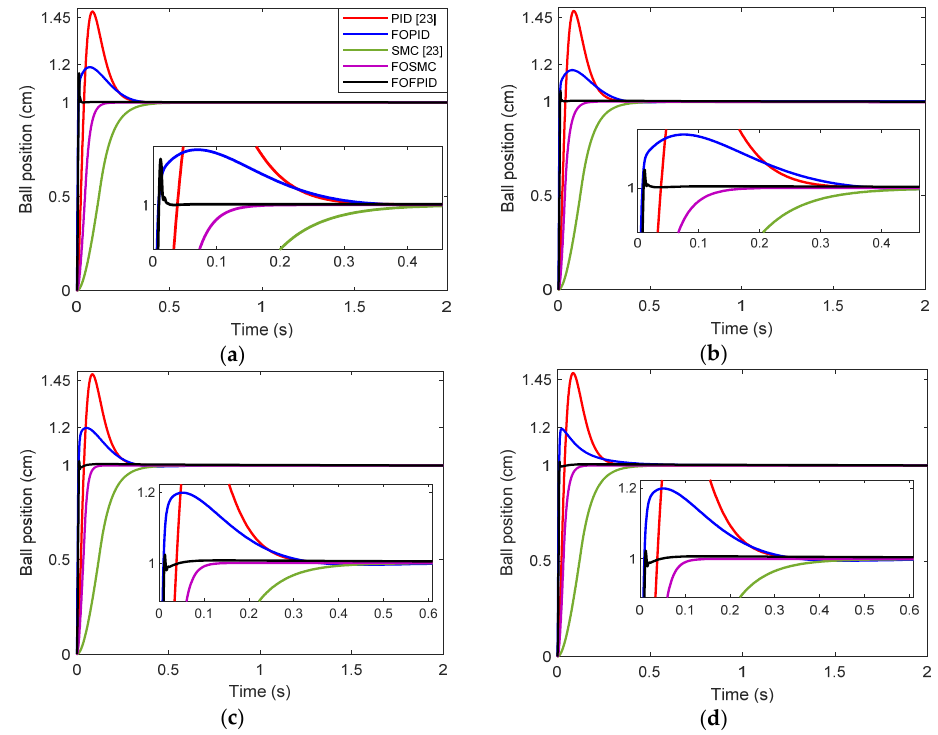
Figure 7. Step responses of the closed-loop Maglev system with different controllers based on J IAE ( a ), J ISE ( b ), J ITAE ( c ) and J ITSE ( d